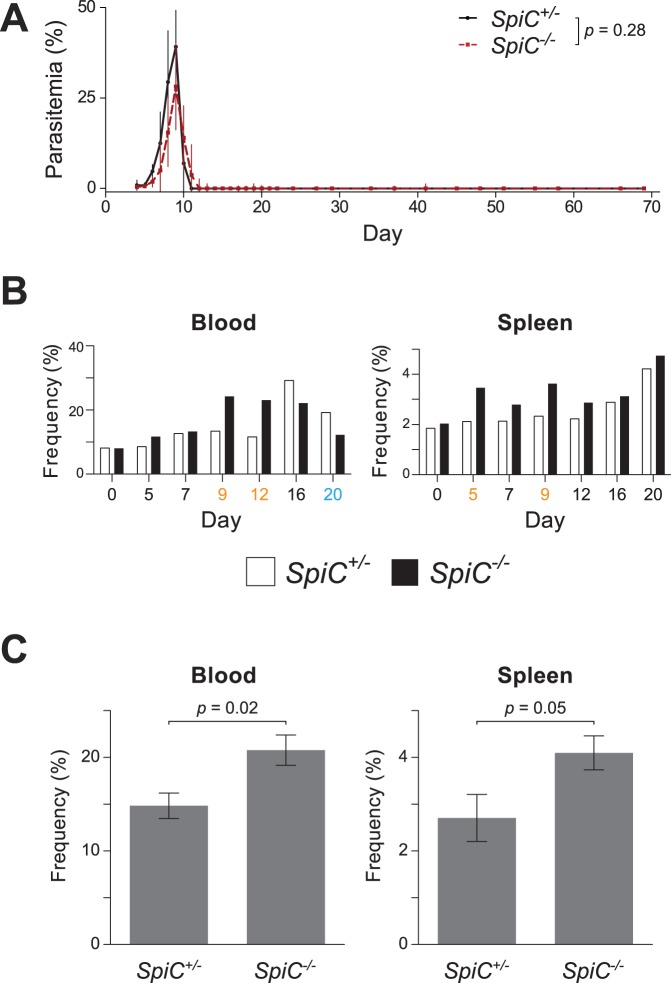
Mice lacking RPMs exhibit wild type infection kinetics.(A) Parasitemia courses in 129Sv SpiC+/− (n = 4) and SpiC−/− (n = 5) mice are represented as geometric means with standard deviations and Mann-Whitney p-value. (B) Ly6clo monocyte (CD11b+ F4/80+ Ly6g− SSClo Ly6clo) frequencies in blood and spleen of 129Sv SpiC+/− (white bars) and SpiC−/− mice (black bars) during the course of infection. Days depicted in blue and orange represent a 1.5-fold decrease or increase, respectively, in Ly6clo monocyte frequencies in blood and spleen of mice infected with P. chabaudi. (C) Ly6clo monocyte frequencies on day 12 post-infection. Means are presented with standard errors; p-values represent a two-tailed t-test assuming unequal variances. Data represent three independent experiments (n = 6–7 mice per group total).